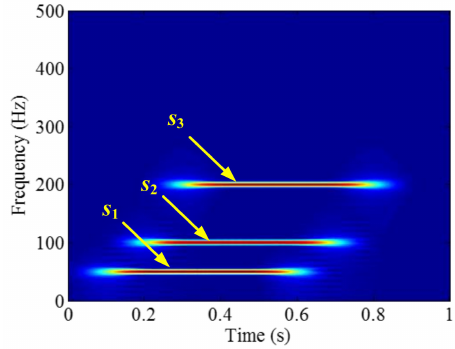
Figure 8. The STFT of the sample signal f sig 2 .